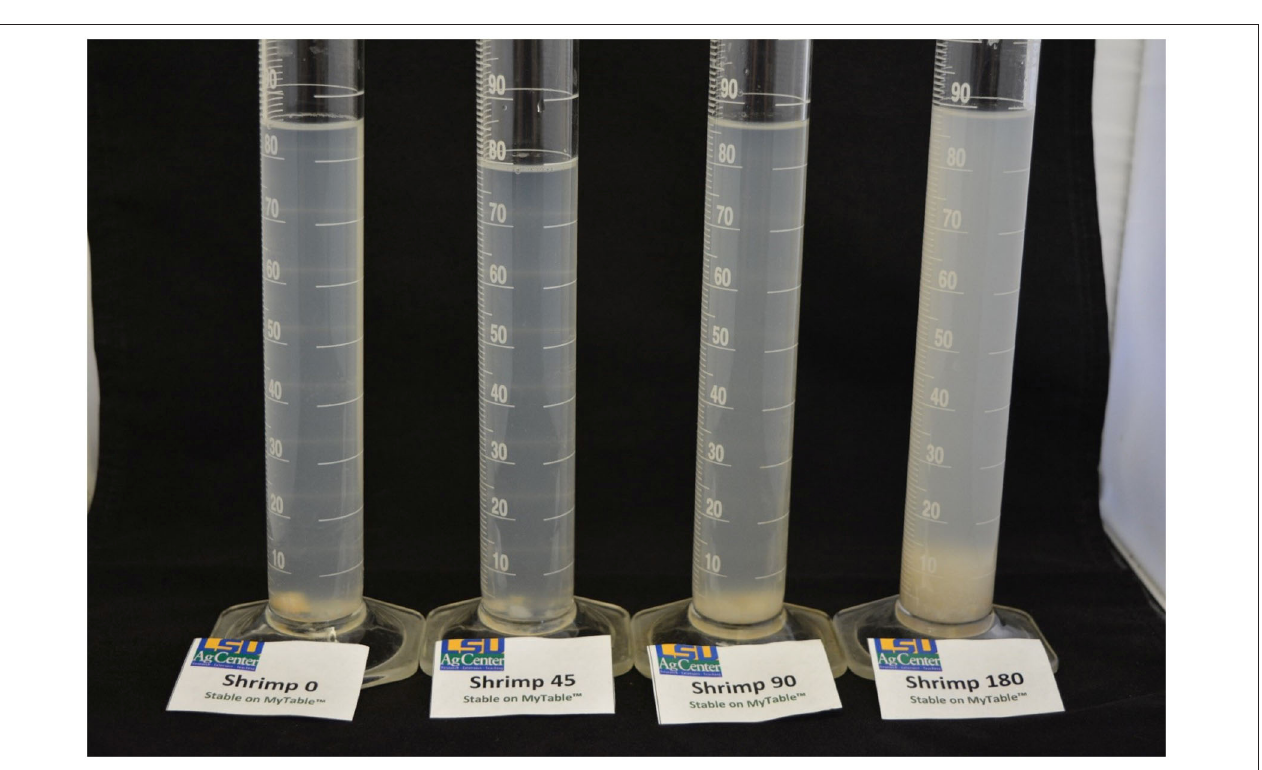
higher agitation speeds, the data showed that 90 SPM agitation speed achieve increased shear force and minimal changes in shrimp